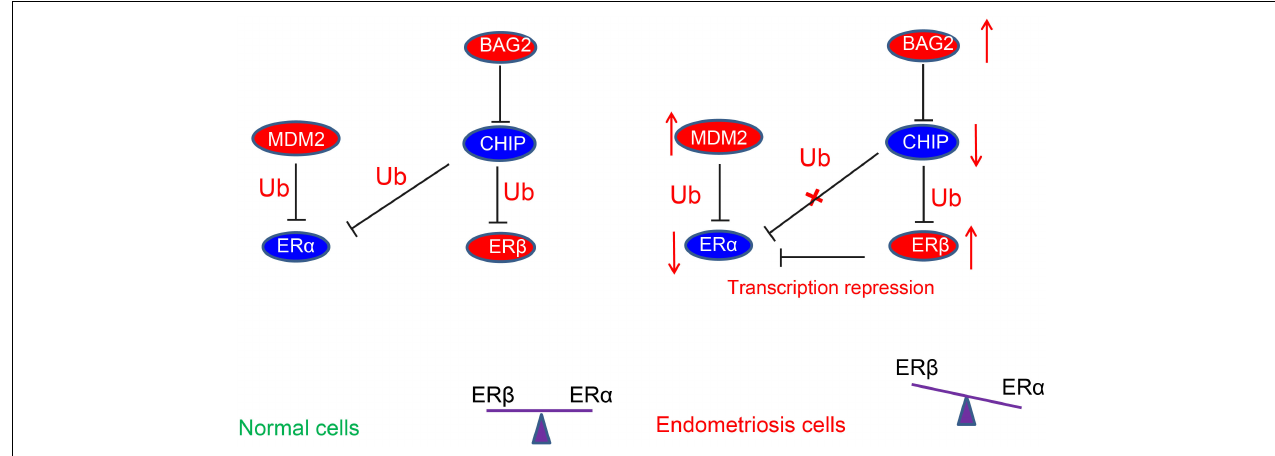
FIGURE 8 | Schematic diagram depicting the regulatory mechanism underlying abnormal estrogenic activity in endometriosis. The high expression of BAG2 in the endometrium reduces the degradation of ubiquitinated ER β by CHIP, thus increasing the protein expression of ER β . On the other hand, the high expression of MDM2 increases the degradation of ubiquitinated ER α and diminishes the protein expression of ER α , leading to a notable increase of ER β /ER α ratio, thereby inducing